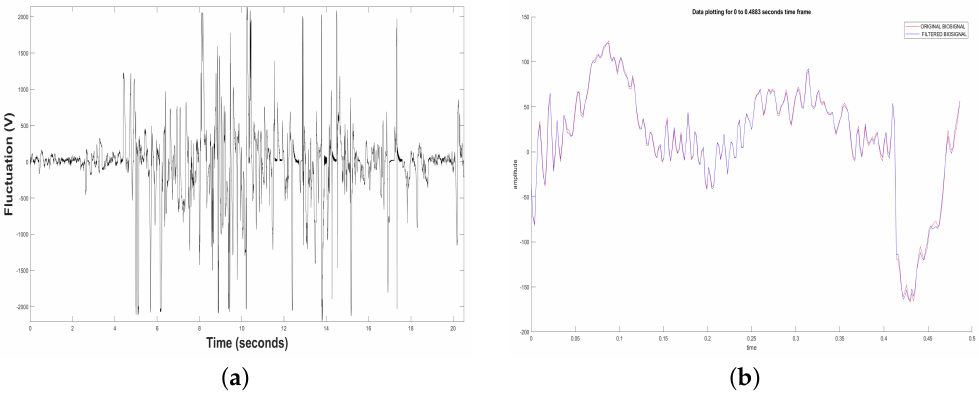
Figure 2. ( a ) Original Time Series. ( b ) Filtered Time Series by means of a notch